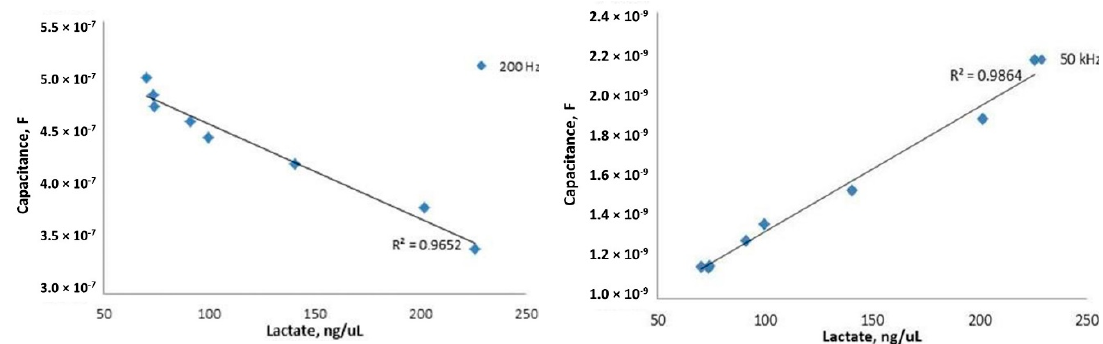
Figure 4. Capacitance calibration curves at 200 Hz ( left ) and 50 kHz ( right ), with R 2